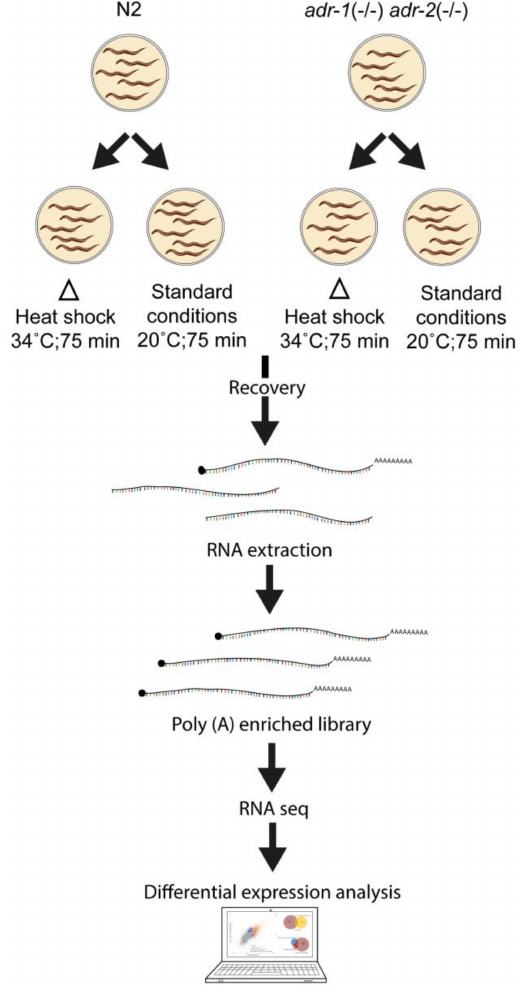
Figure 1. Schematic view of the heat-shock